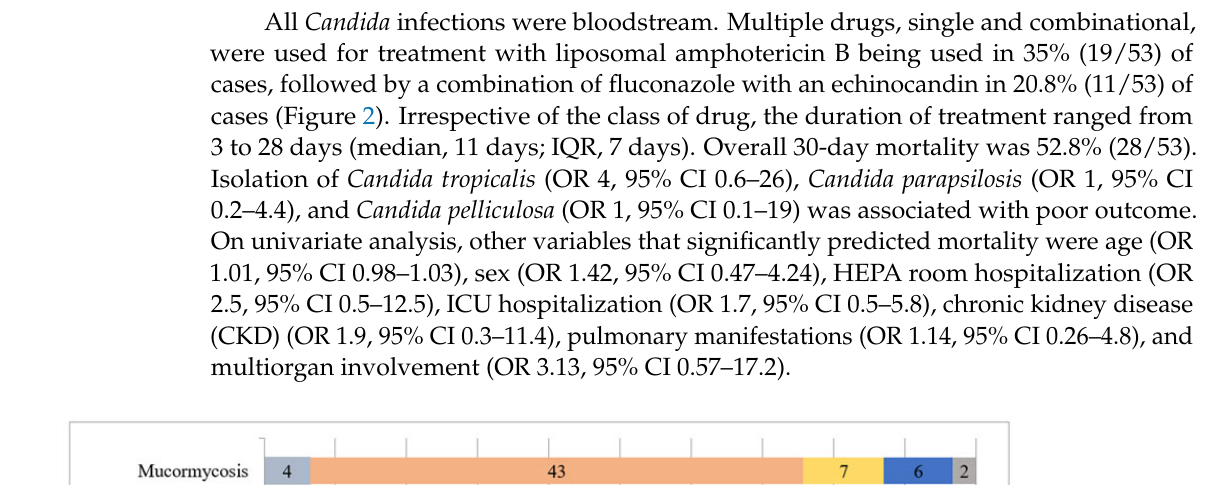
Figure 3. Clinical characteristics of Cryptococcosis.